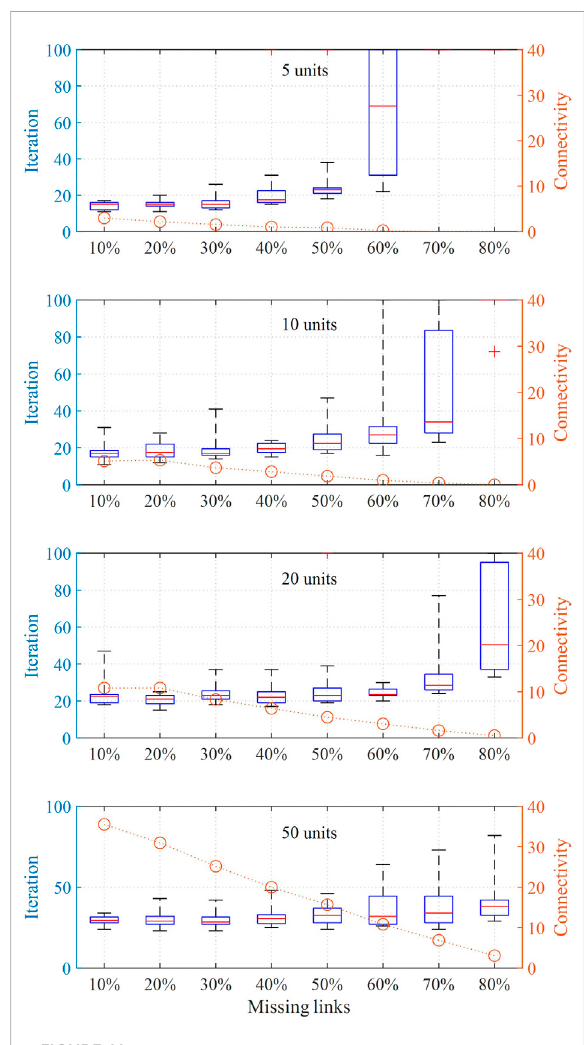
simulation systems with different numbers of ESUsNomenclature.